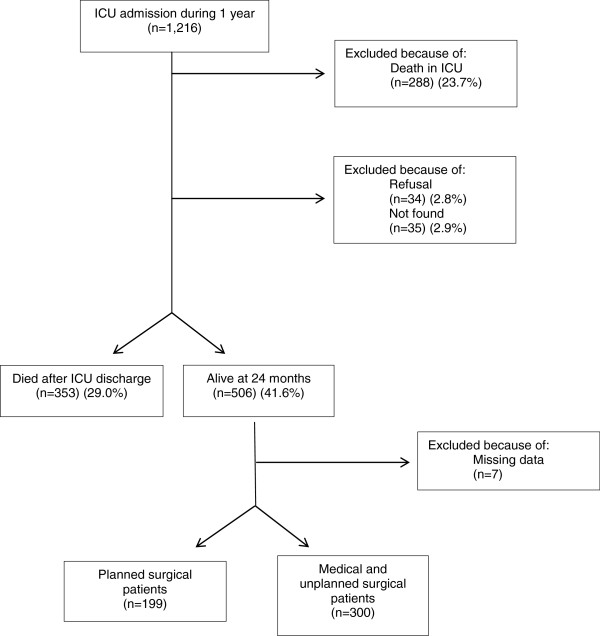
Enrolment scheme.